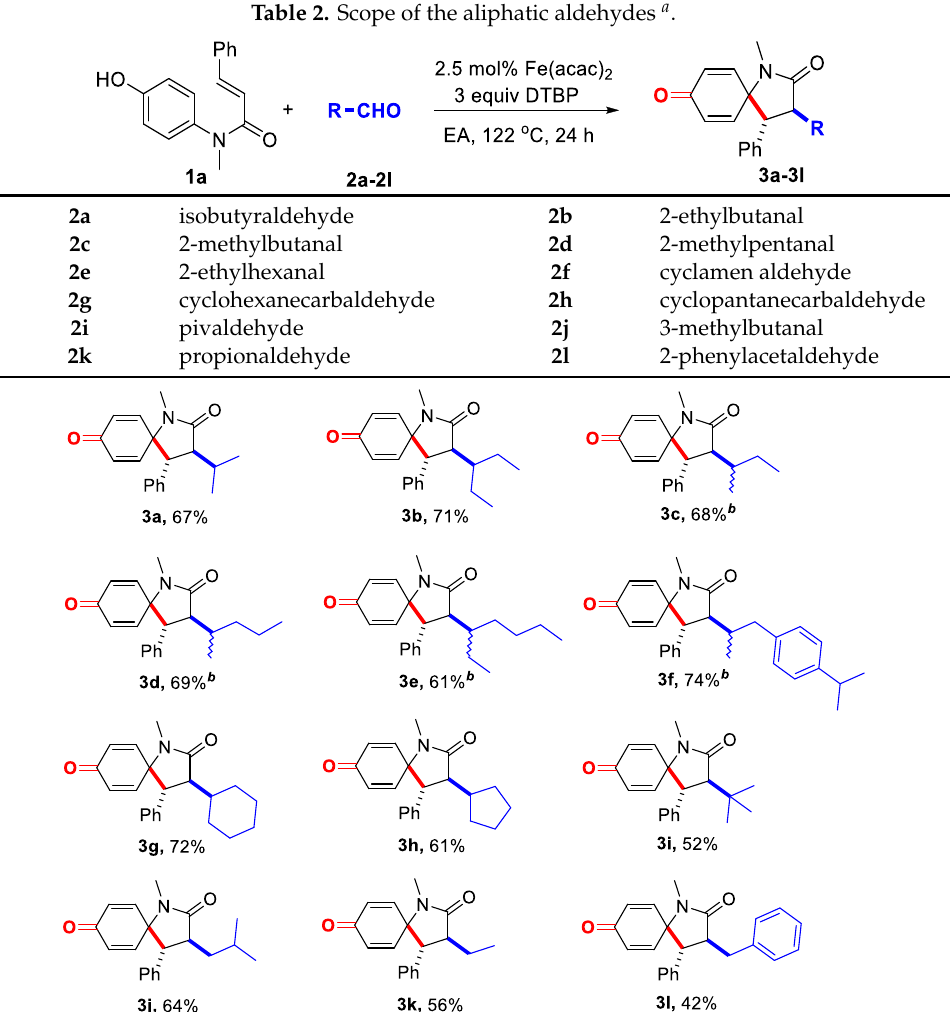
Table 2. Scope of the aliphatic aldehydes a .